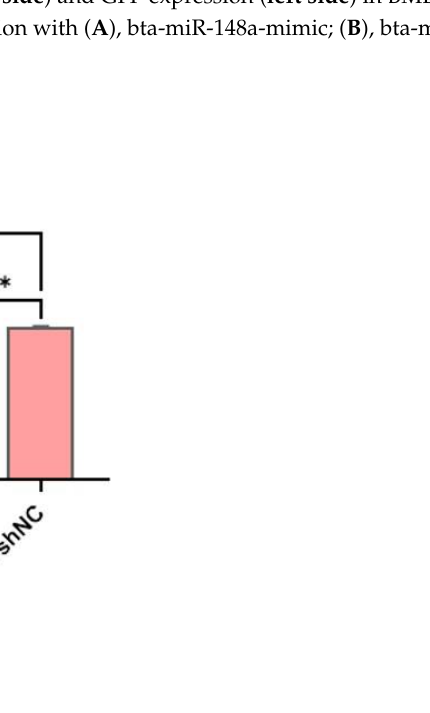
Figure 2. Relative expression of bta-miR-148a in BMECs after 24 h of transfection with bta-miR-148- mimic, bta-miR-148a-inhibitor, and bta-miR-148a-shNC. *** p <